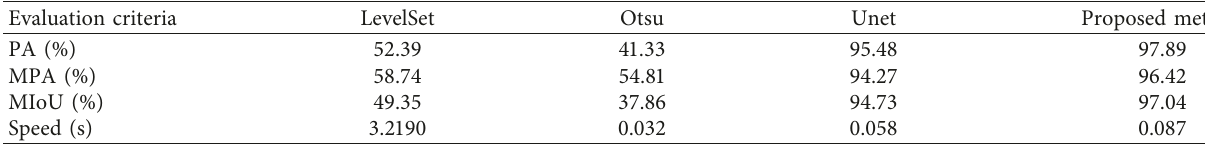
Figure 18: Ship detection results. Table 5: Index comparison of different segmentation algorithms.